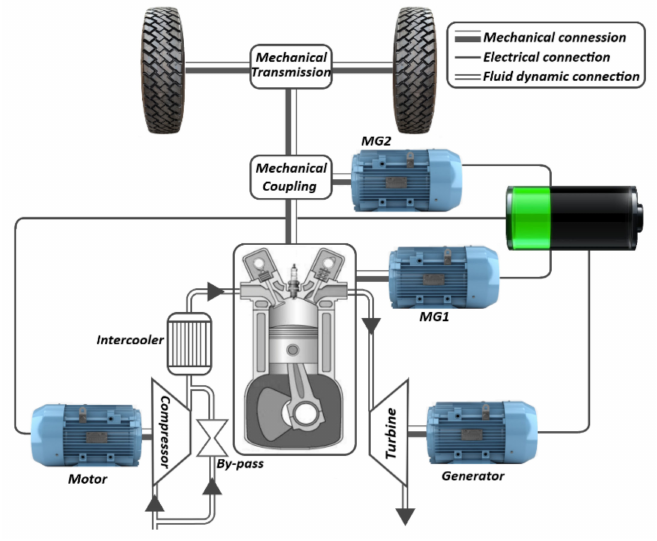
Figure 3. Hybrid propulsion system endowed with the proposed compound engine (MG1 and MG2 = motor-generator